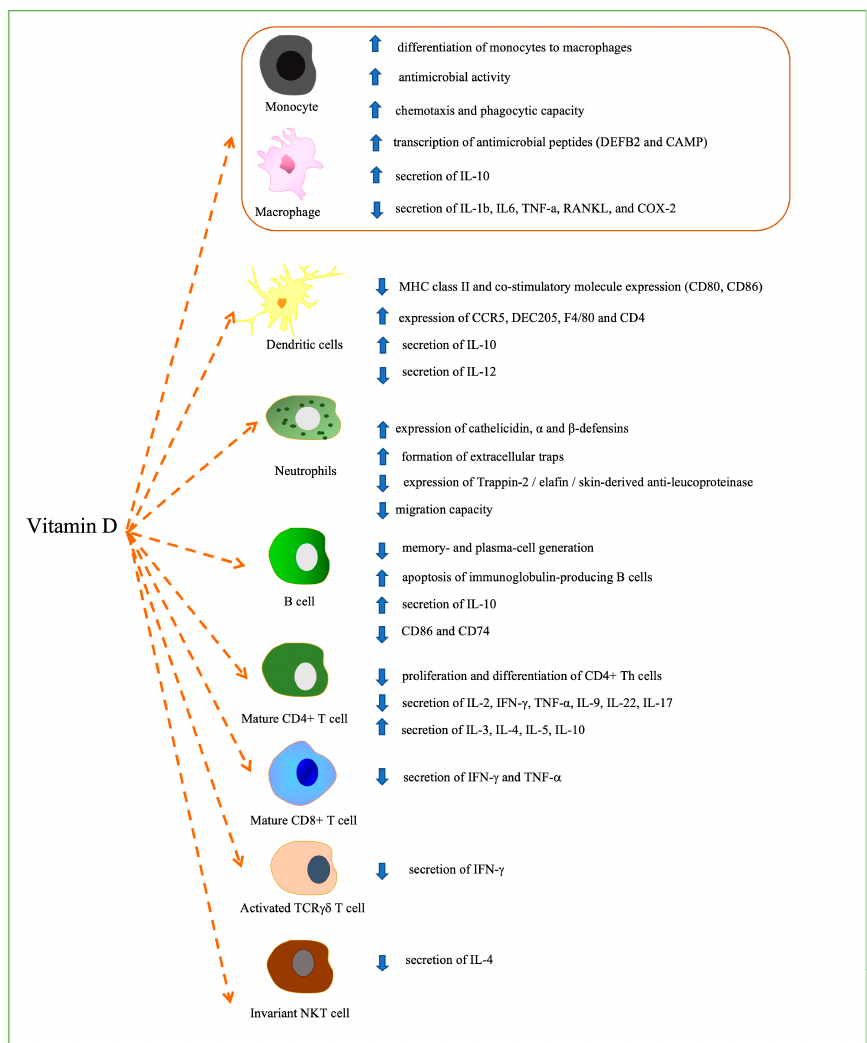
Figure 1. The effects of vitamin D on immune cells.